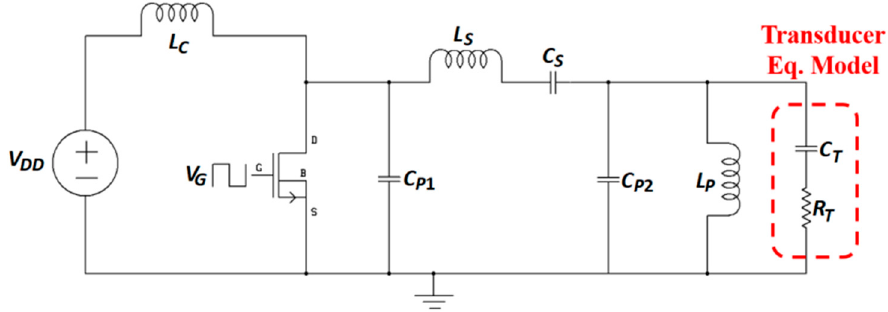
Figure 42. Shunt-C class-E amplifier.